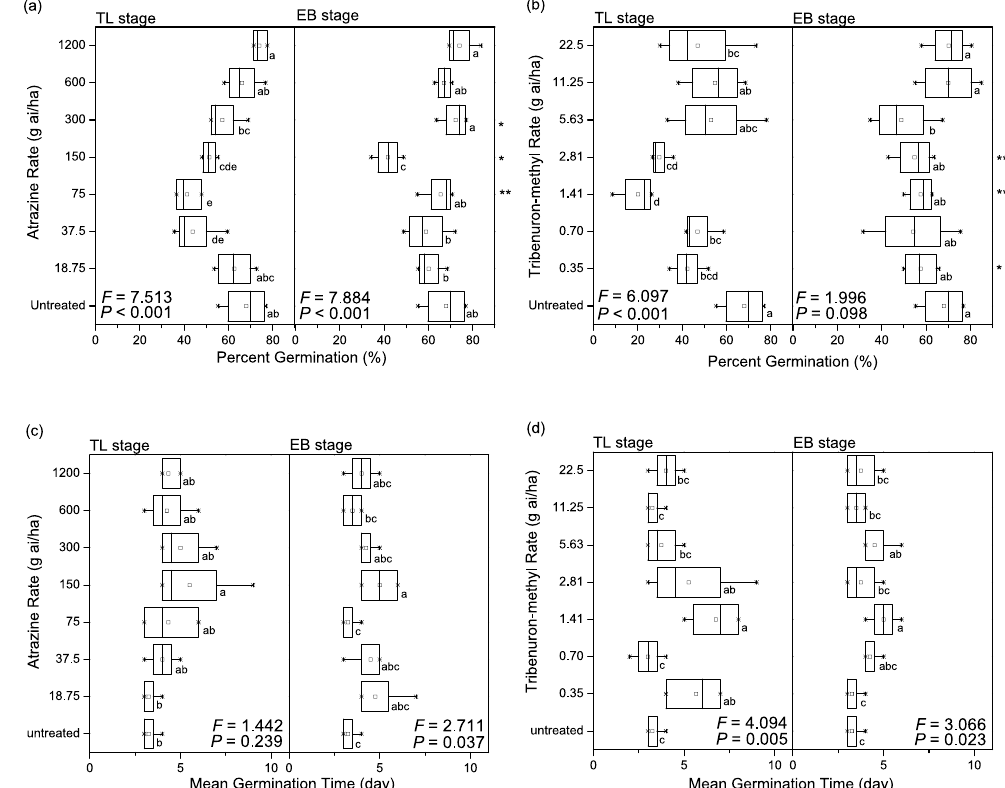
Figure 1. Percent germination ( a,b ) and mean germination time ( c,d ) of seeds produced after the 12 to 14 true leaves stage (TL stage) and the early blooming stage (EB stage) treated with atrazine ( a,c ) or tribenuron- methyl ( b,d ). In the boxplots here, the ends of the box represent the 25 th and 75 th percentiles; the bars inside the box represent the 50 th percentile, or the median, and the ends of the whiskers represent the minimum and maximum values. Means are represented by solid circles. Different letters indicate significant difference between different doses of the same herbicide at α = 0. 05. * Shows the influence of different plant growth stages treated with the same herbicide dose according to the independent-sample t test. * P < 0.05, ** P < 0.01.